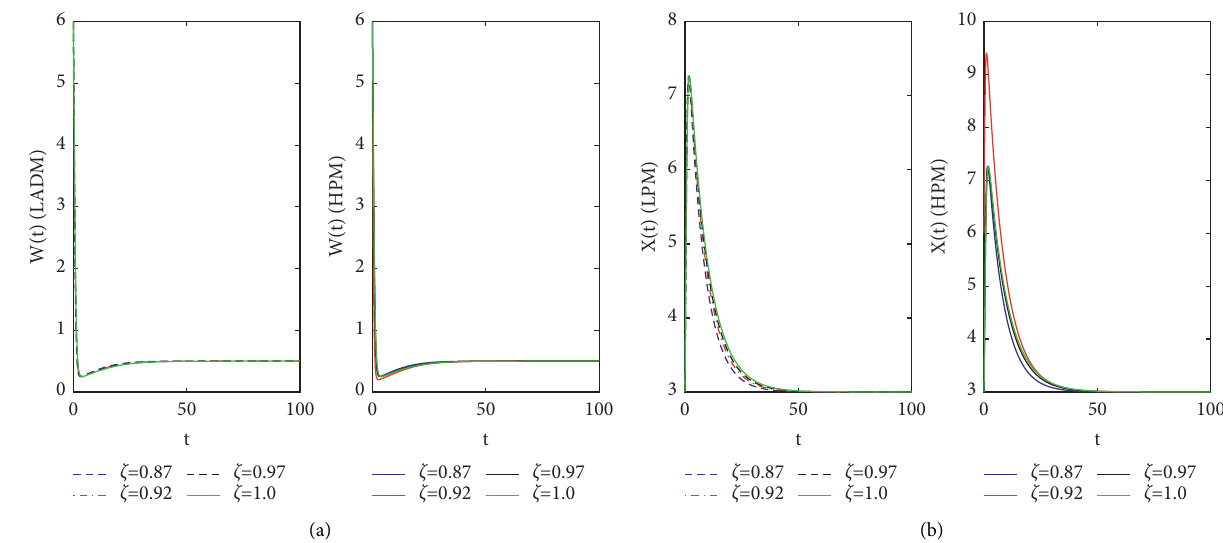
Figure 2: Comparison of LADM and HPM for the series solution of ( W ( t ) , X ( t )) for various arbitrary orders of the considered model (2). (a) Comparison of LADM and HPM for the series solution of W(t) for various arbitrary orders. (b) Comparison of LADM and HPM for the series solution of X(t) for various arbitrary